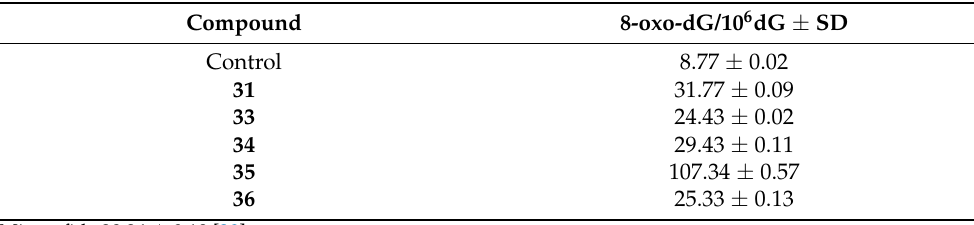
Table 2. 8-Oxo-dG level in cellular DNA after treatment with compounds 31 and 33 – 36